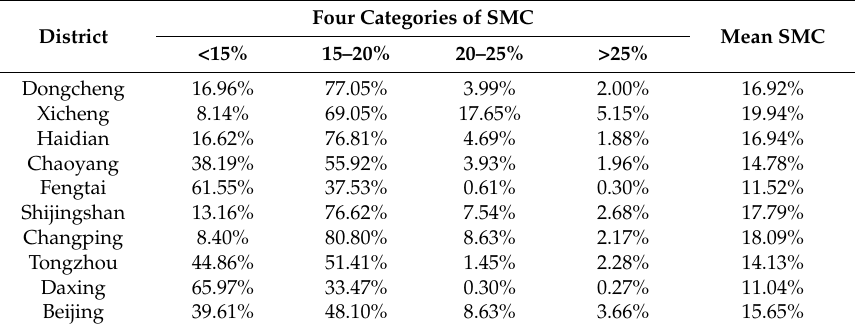
Table 2. The mean values of SMC in the nine districts and